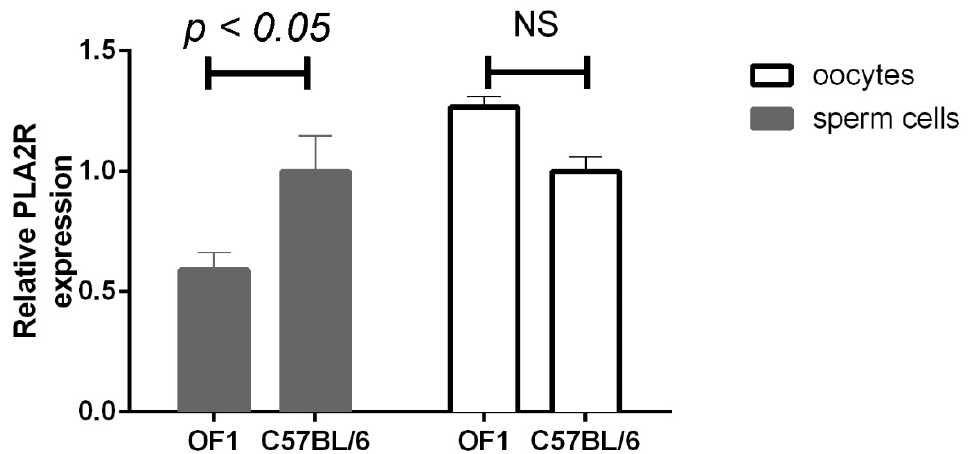
Figure 11. Comparative expression of Pla2r1 in both gametes from OF1 and C57BL/6 strains. RNAs were extracted from 2 caudae epididymides and 50 oocytes at the germinal vesicle stage from OF1 and C57BL/6 males and females and their expression compared by RT-qPCR. Statistical comparisons were made with a paired t -test; no statistical difference (NS).